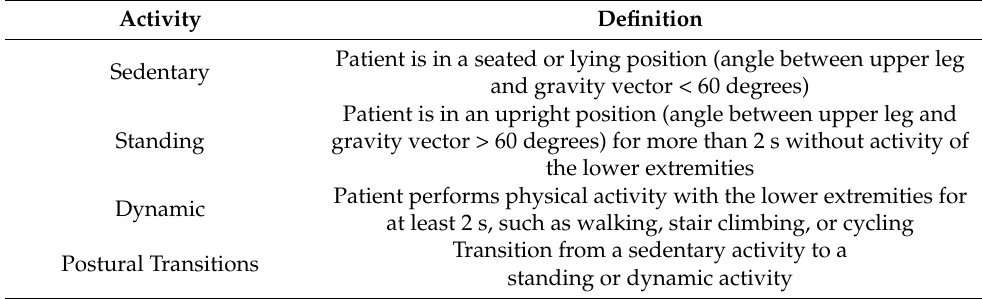
Table 1. Definitions for activity classification of the video